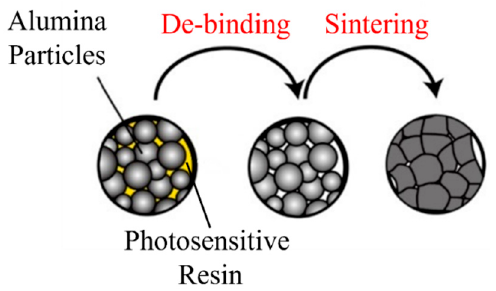
Figure 5. Schematic of thermal treatment process of stereolithography composite “green” parts.